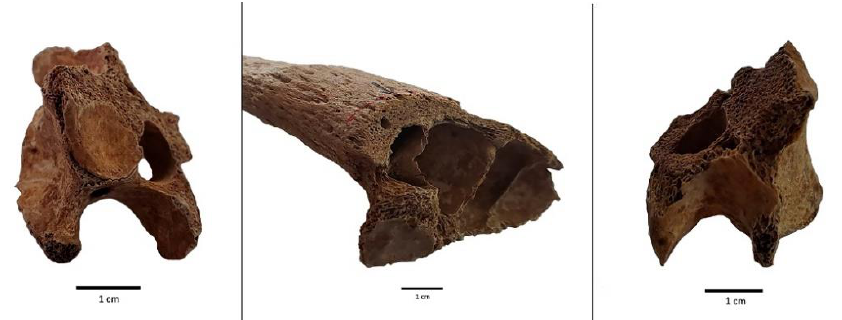
Figure 16. Examples of Class 5 complete chop marks from Göltepe ( left to right : Ovis/Capra vertebra, MRN 2299, bone 13; Capra hircus horn core, MRN 3433, bone 35; Ovis/Capra vertebra, MRN 2299, bone 12).